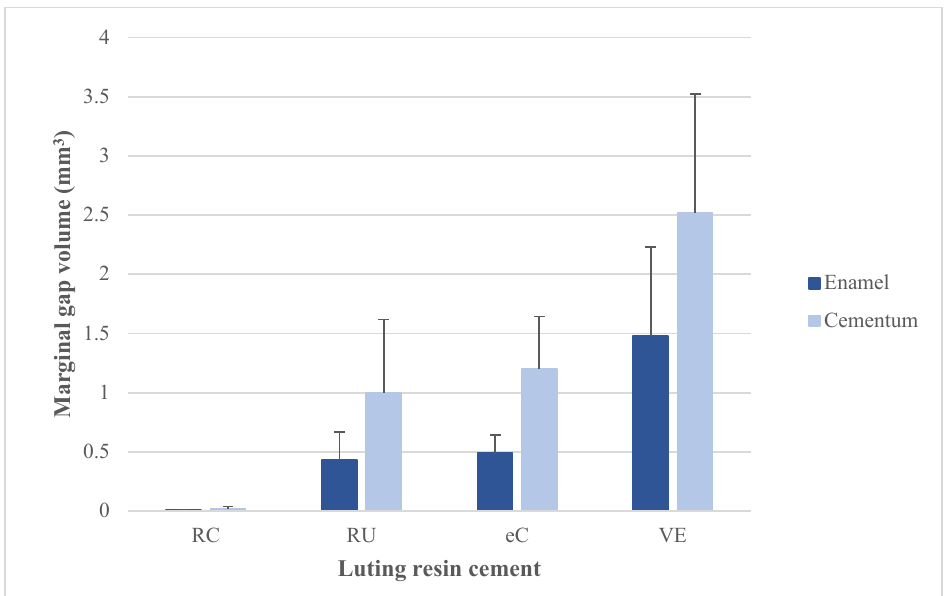
Figure 5. Mean internal gap volume (mm 3 ) of inlay restoration associated with different resin ce- ments on enamel vs. cementum/dentin surfaces.